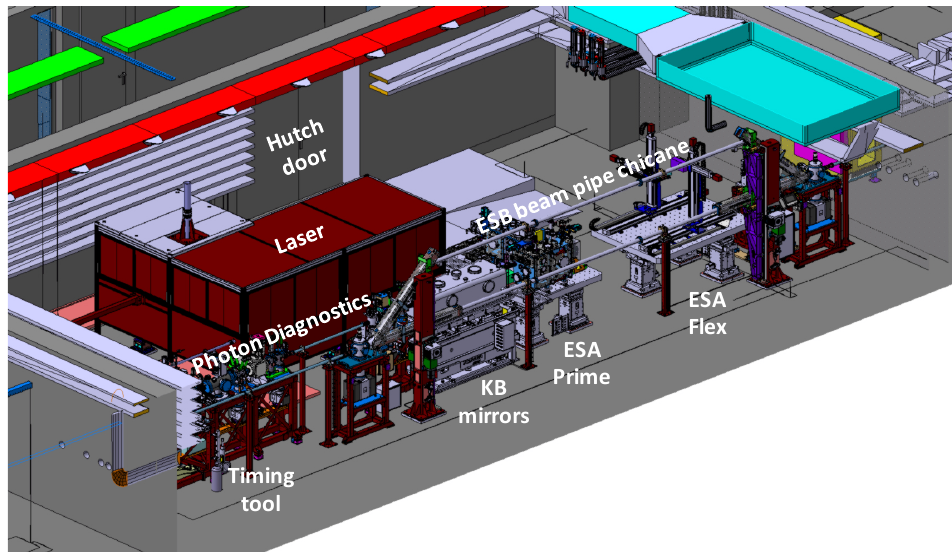
Figure 13. The Experimental Station Alvra X-ray hutch. The X-rays come from the Optics hutch, to the left of the schematic and move from left to right in the figure. The various components located in the hutch are labelled. The ESB beam pipe chicane is a motorized beam pipe that can be moved vertically to either allow the XFEL beam to be delivered to Bernina, or to allow easy access to the Alvra instruments. The same motorized elements will be used in a similar fashion for an ESC beam pipe chicane in the